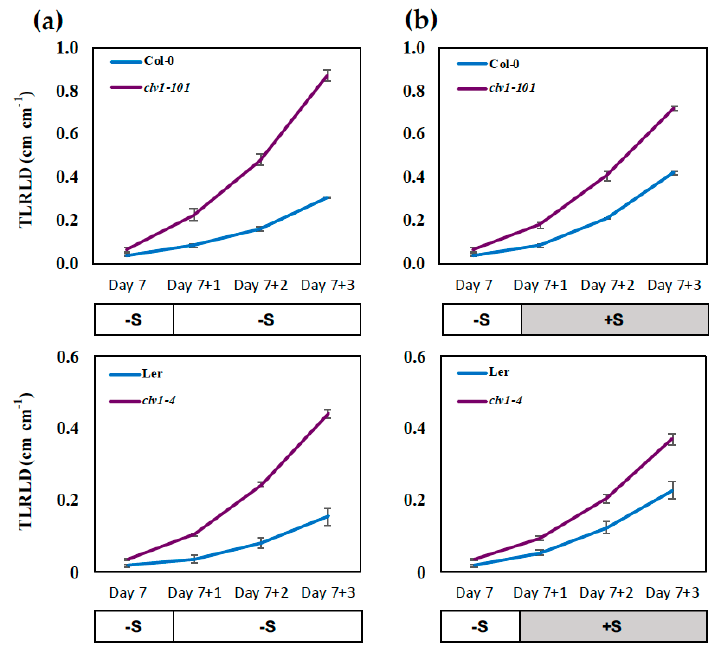
Figure 4. Effect of S supply on total lateral root length density (TLRLD). Wild-type (Col-0 and L er ) and clv1 mutant lines ( clv1-101 and clv1-4 ) were grown vertically on –S (15 µ M sulfate) medium for 7 days and then transferred to ( a ) –S medium or ( b ) + S medium to be grown subsequently for 3 days. TLRLD was calculated at each time point based on the lengths of the entire LR in one seedling and the length of the PR. Values show means (± SE) of 24 individual plants per treatment.